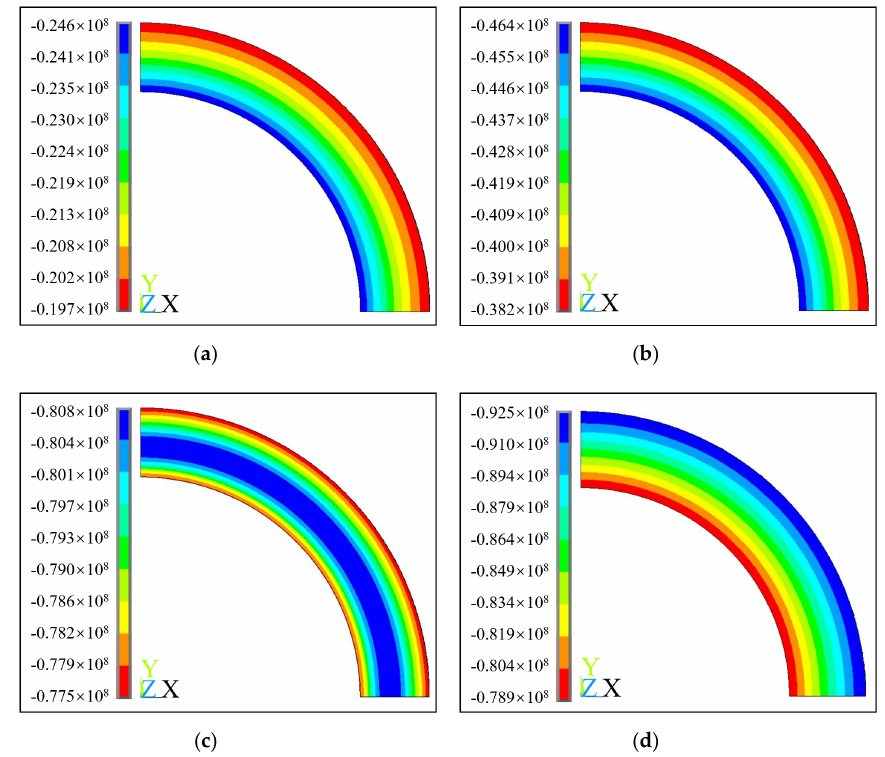
Figure 5. Hoop stress cloud diagrams of D-8 model shaft lining concrete under a surface load: ( a ) 5 MPa; ( b ) 10 MPa; ( c ) 19 MPa; ( d ) 25.3 MPa. ( b ) 10 MPa; ( c ) 19 MPa; ( d ) 25.3